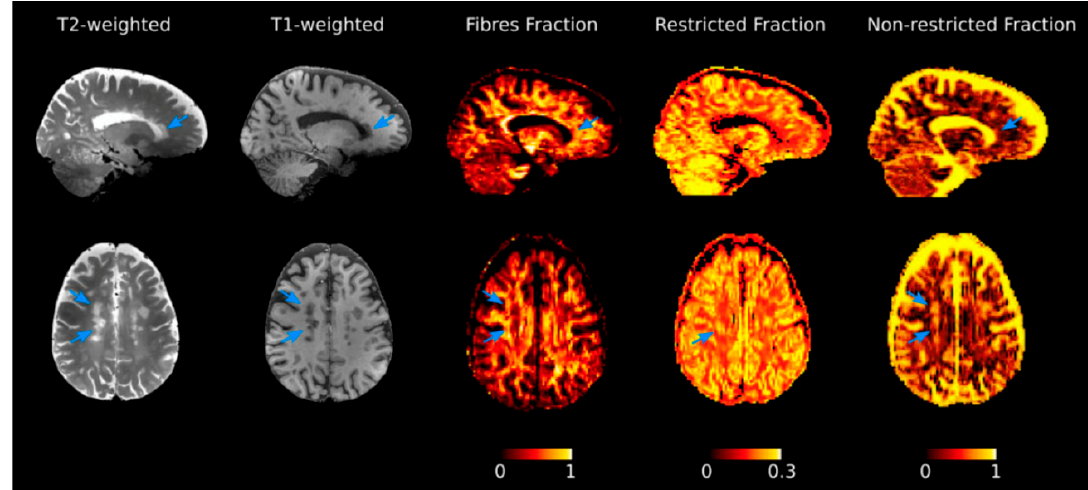
Figure 1. Diffusion basis spectrum imaging (DBSI) maps for the investigation of tissue properties. Selected T2- and T1-weighted images, together with DBSI-derived maps from a patient diagnosed with multiple sclerosis. Variations of each metric in normal appearing tissue in comparison with lesions (indicated by arrows) can be appreciated. The color bar expresses each DBSI-metric adimensional unit of measure. Reprinted from Brain , Vol. 144, Issue 1, P213–223, 12 February 2021. Schiavi S. et al. “Non-invasive quantification of inflammation, axonal and myelin injury in multiple sclerosis” [42]. Copyright: © 2021, with permission from Oxford University Press.